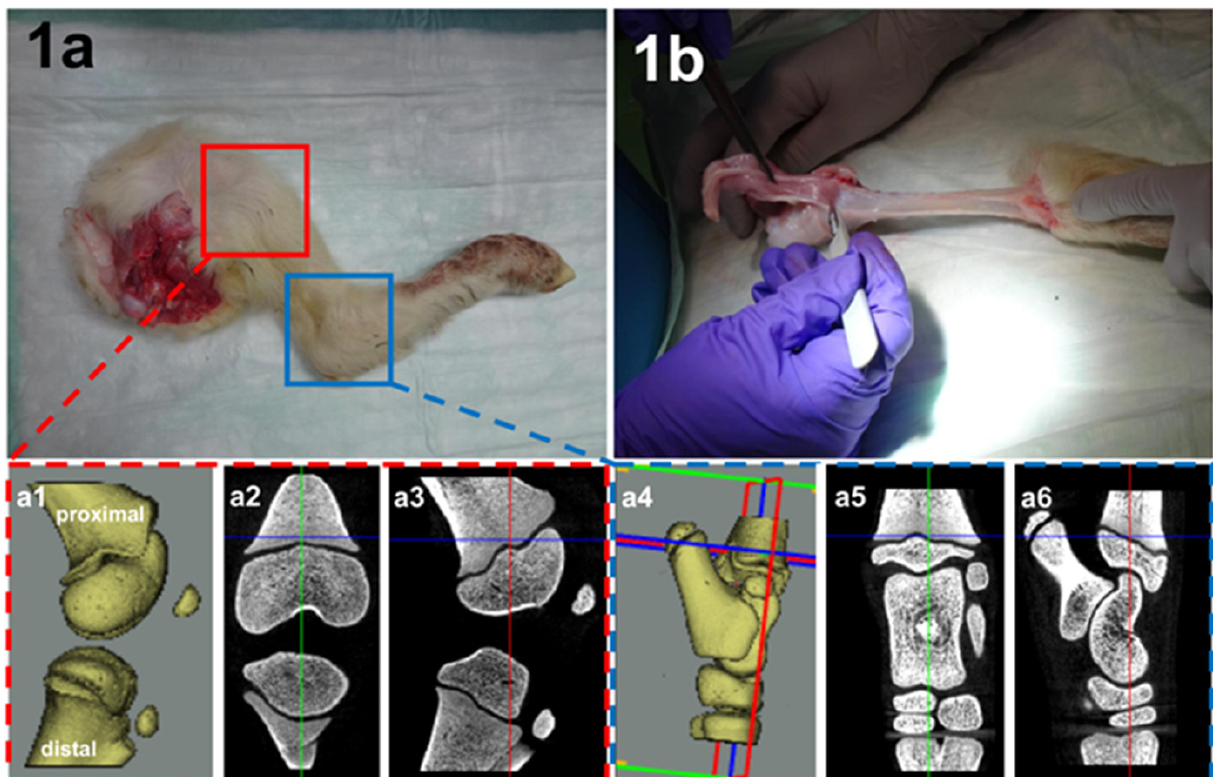
Figure 1. Hind leg separated from the stillborn female linseed sheep ( a ). Anatomical preparation through the muscles up to the appearance of the bone ( b ). The small red box marks the knee joint. The magnification in the dashed box shows a sagittal 3D overview in micro-CT imaging ( a1 ), ( a2 ) coronal sectioning, and ( a3 ) sagittal sectioning through the knee joint. The small blue box marks the ankle. The magnification in the dashed box shows a sagittal 3D overview in the micro-CT imaging ( a4 ), ( a5 ) coronal sectioning, and ( a6 ) sagittal sectioning through the ankle.